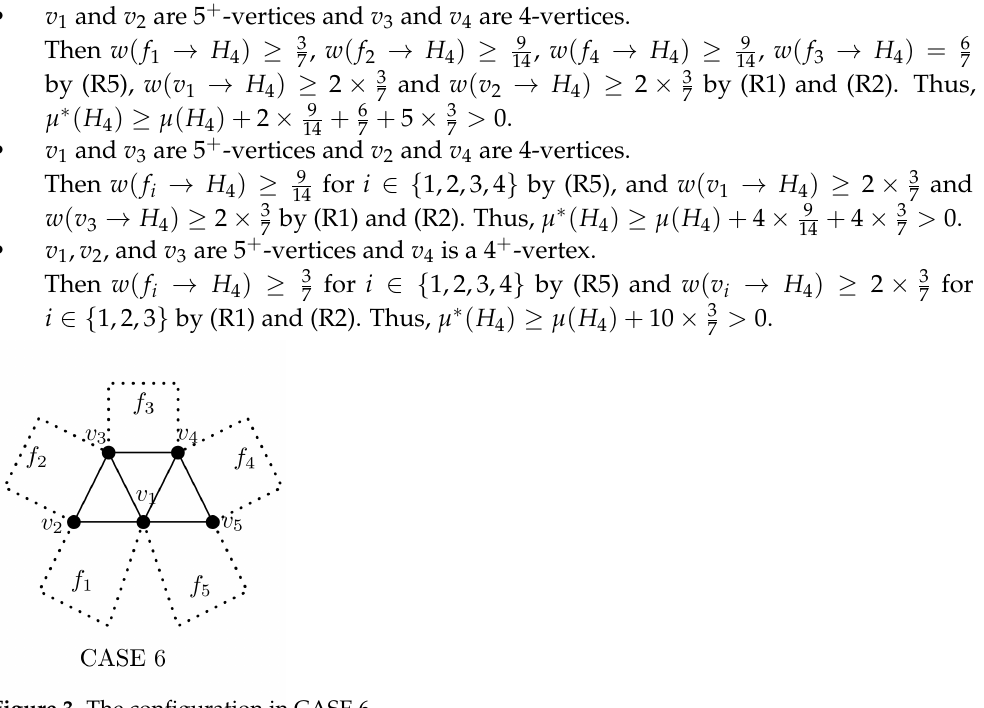
Figure 3. The configuration in CASE 6.